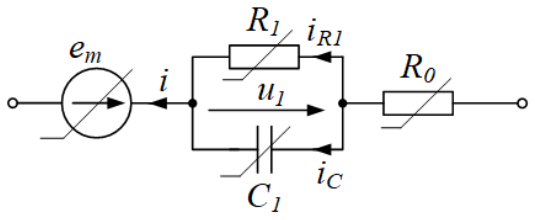
Figure 5. Equivalent diagram of an electrochemical cell [34].